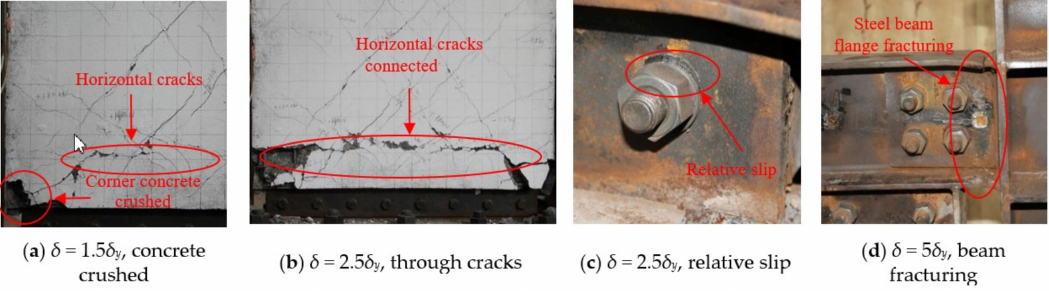
Figure 7. Local failure of